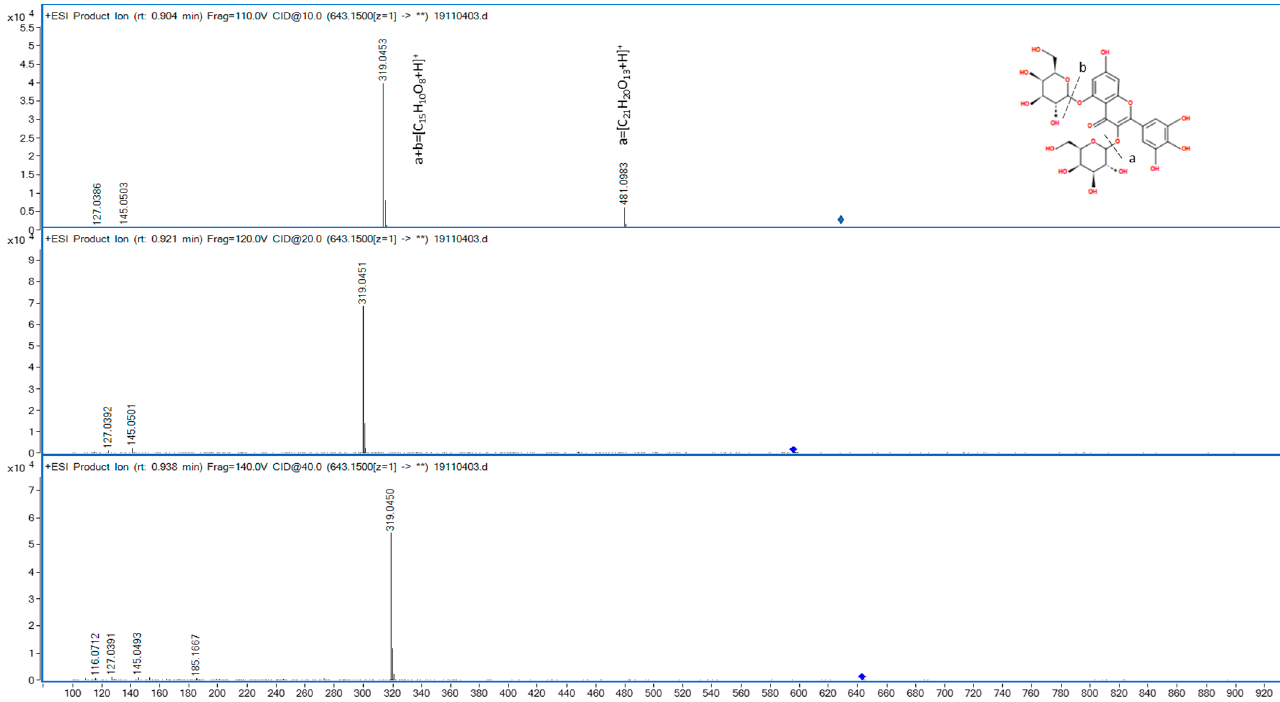
Figure 1. High resolution mass spectrum of myricetin diglucoside (643 m / z ). The compound F7 was detected both in positive and negative polarity with an ac- curate mass of m / z 713.1930 and m / z 711.1776 respectively (Table 2). Moreover, the tar- geted MS/MS experiment showed the formation of two main product ions at m / z 551.1399